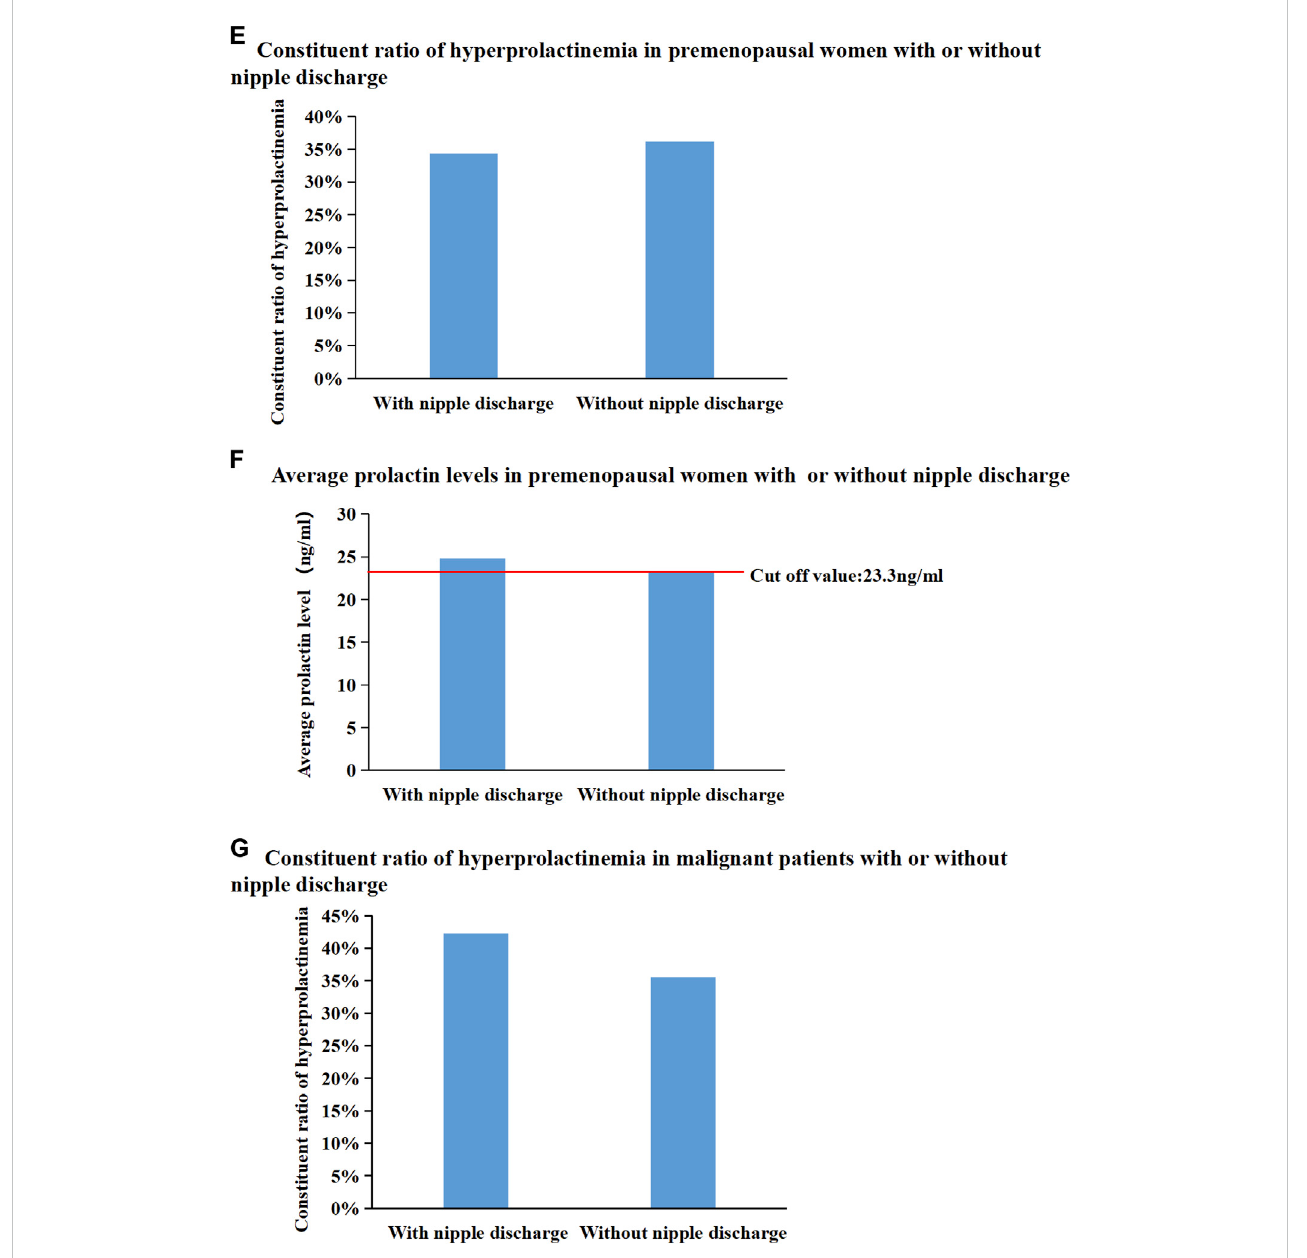
Interestingly, the proportion of patients with IDP in these two age groups was almost similar (16% vs. 18%, Figure 3C).